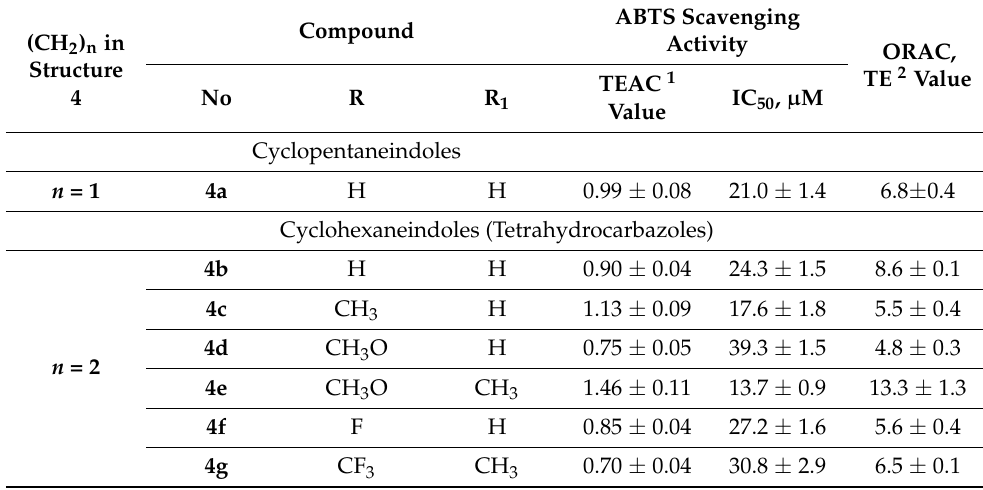
Table 3. Radical scavenging activity of MB -cycloalkaneindoles conjugates according to ABTS and ORAC-FL